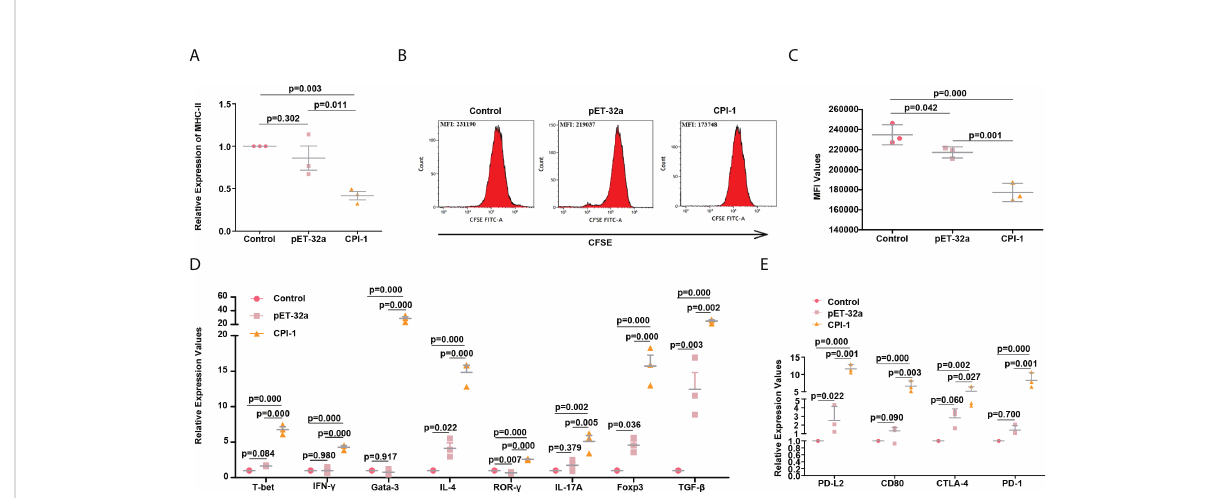
FIGURE 9 rBsCPI-1 affects the antigen presentation process of MDMs and the proliferation and activation of CD4+ T cells. (A) qPCR analysis of the relative expression of MHC-II. (B) FCM was performed to detect the mean fl uorescence intensity (MFI) of CFSE-labeled CD4+ T cells co-incubated with MDMs which treated with PBS, pET-32a, and rBsCPI-1. (C) The FCM data presented are representative of three independent experiments. (D) qPCR analysis of the relative expression of surface marker molecules of Th1 cells (T-bet and IFN- g ), Th2 cells (Gata-3 and IL-4), Th17 cells (ROR- g and IL-17A), and Treg cells (Foxp3 and TGF- b ). (E) qPCR analysis of the activation of PD-L2/PD-1 and the CTLA-4/CD80 pathway between MDMs and CD4+ T